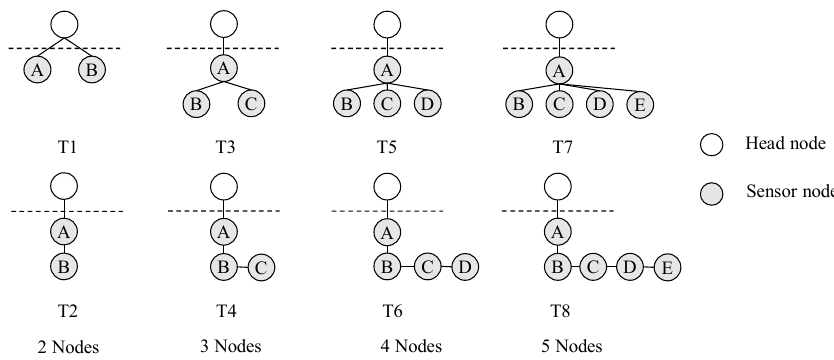
Figure 3. WSN topologies for performance